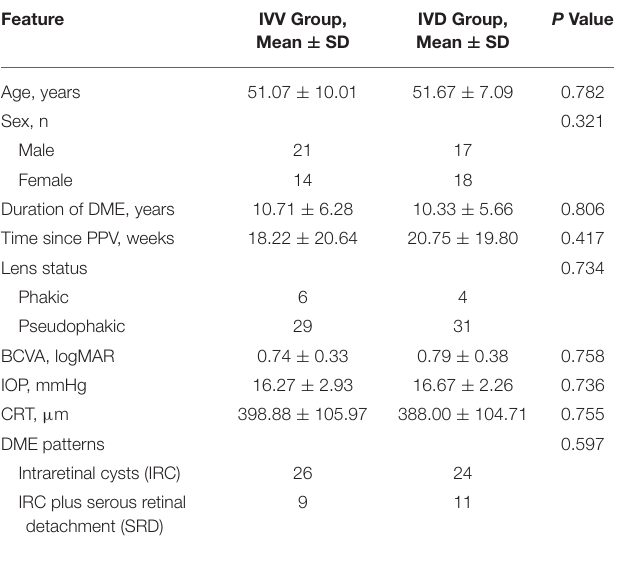
TABLE 1 | Baseline characteristics of the two groups.